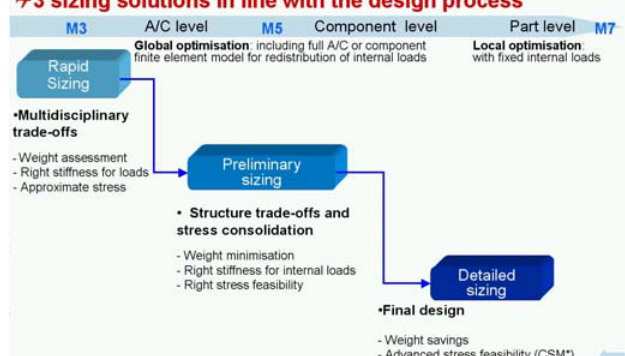
Fig. 8.b. The three sizing solutions proposed to support the